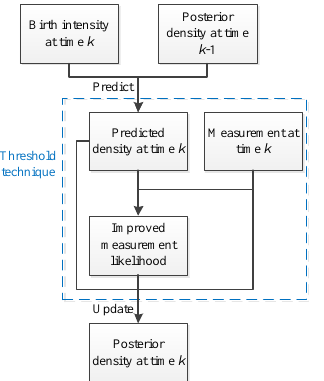
Figure 2. Cardinality balanced multi-target multi-Bernoulli (CBMeMBer) filter with threshold